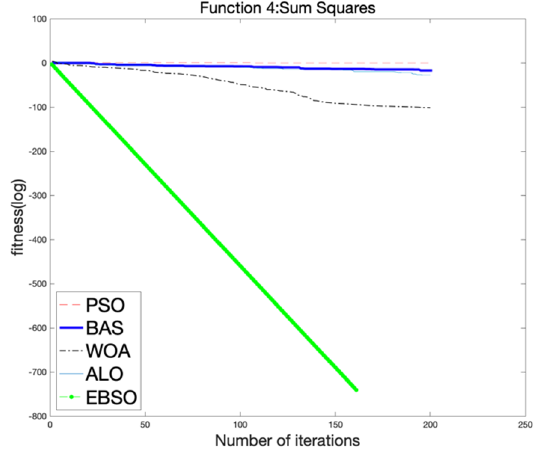
Figure 9. Iterative convergence graph .